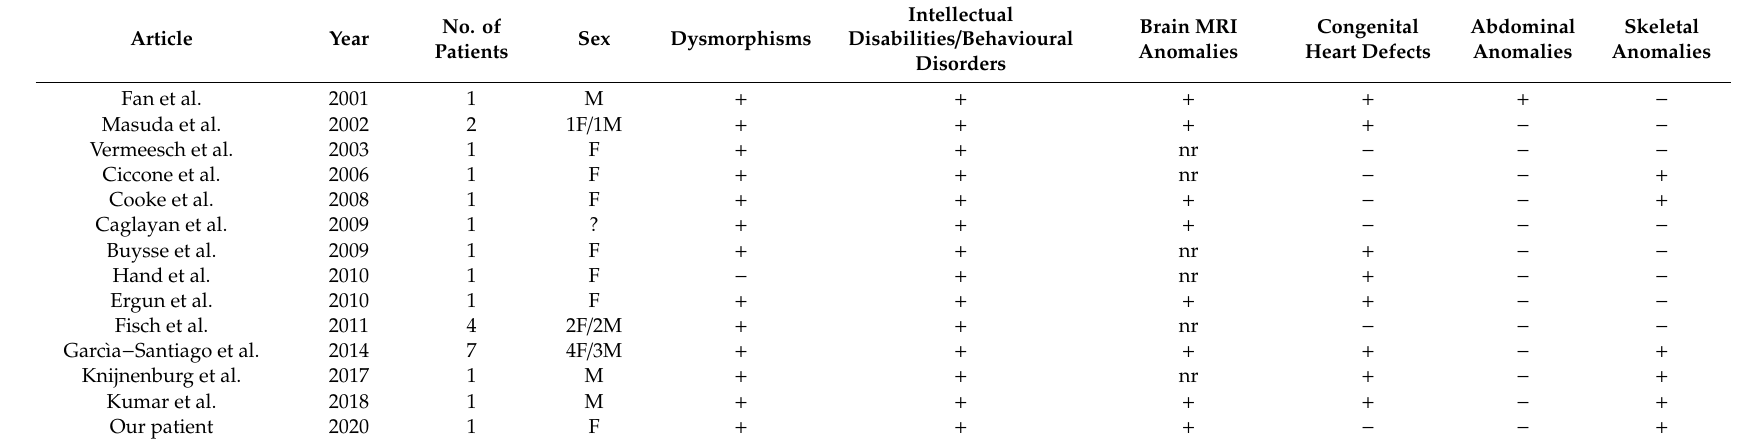
Table 2. Extensive invdupdel[8p] genotype–phenotype correlation analysis and scientific literature review broken out per article, author, year, number of patients described, patients’ sex, and clinical / instrumental reported anomalies. + , retrieved feature; − , not retrieved feature; nr, not reported. Intellectual No. of Brain MRI Congenital Abdominal Year Dysmorphisms Disabilities / Behavioural Patients Anomalies Heart Defects